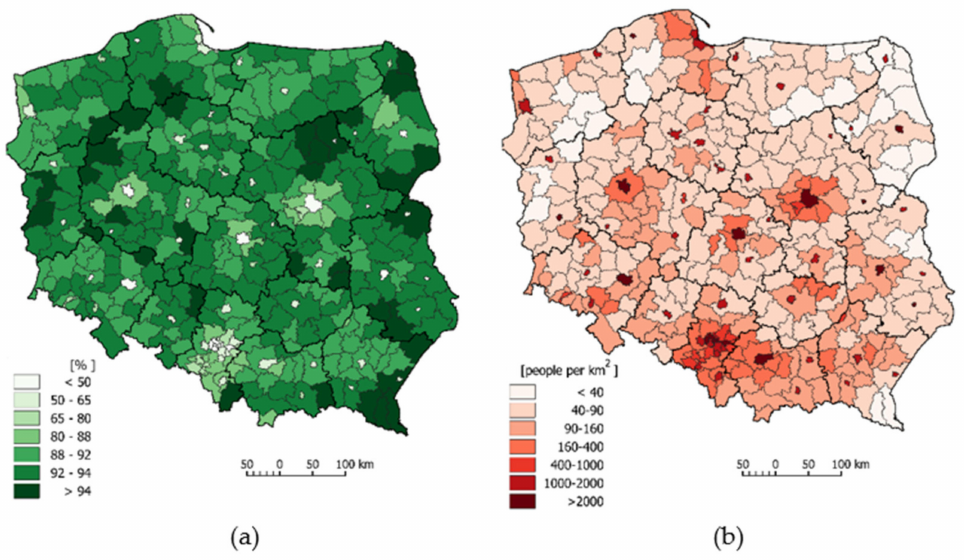
Figure 3. Differences in the values of the indices characterizing: ( a ) green-blue spaces and ( b ) population density in Polish